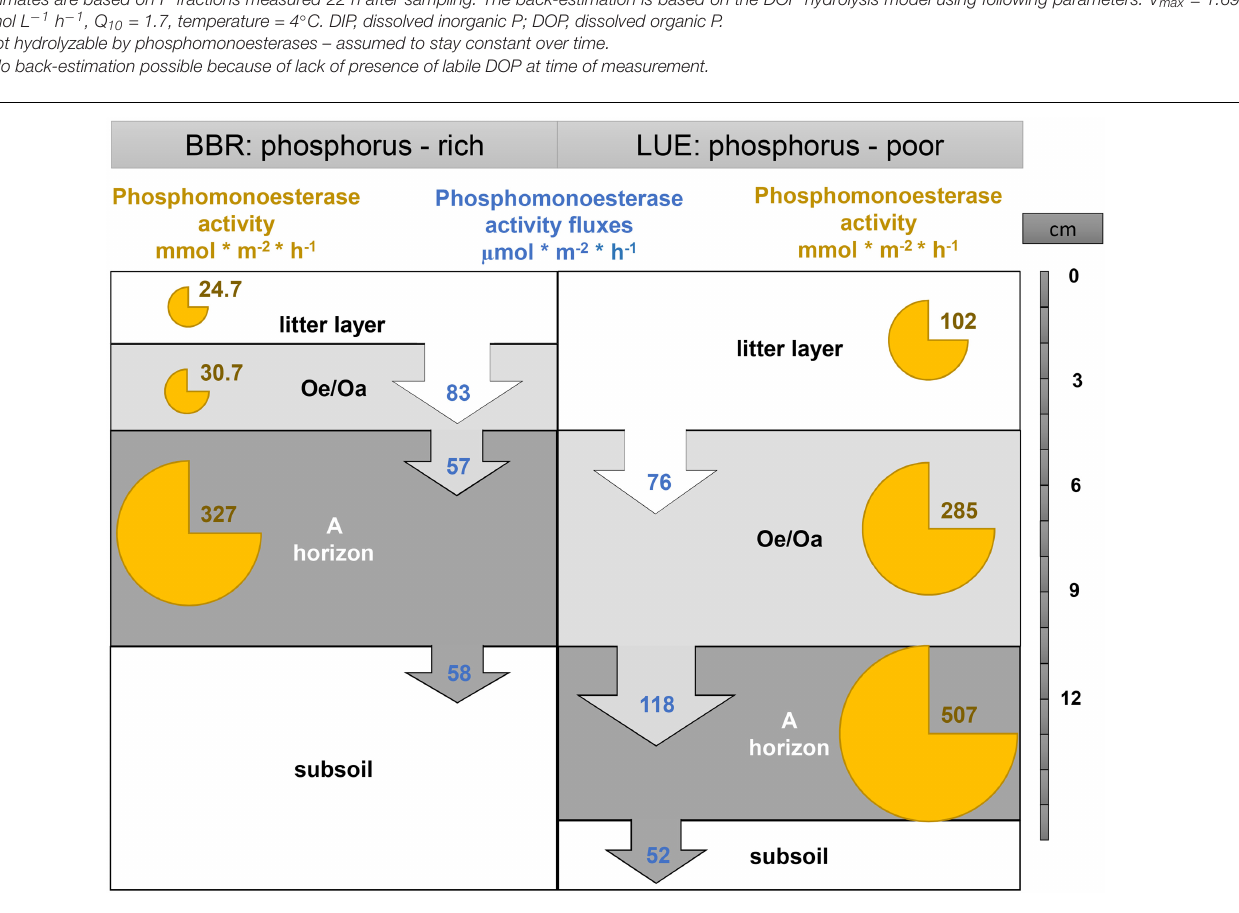
FIGURE 6 | Conceptual model of down-transport of phosphomonoesterase activities in the unfertilized plots with percolating water as compared to total phosphomonoesterase activity per horizon and m 2 (as defined by activity in soil extracts). Phosphomonoesterase activity (V max ) in soil horizon: in mmol m - 2 h - 1 ,